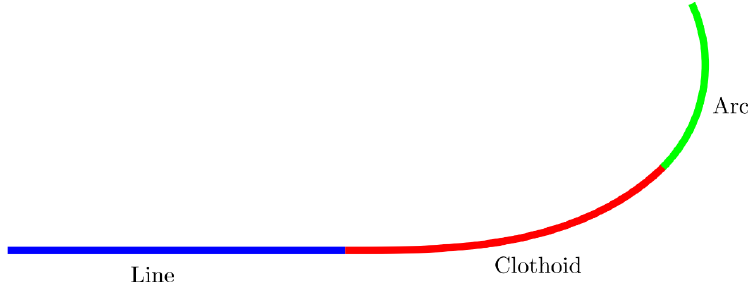
Figure 2. A straight curve and a circular curve connected by a clothoid transition